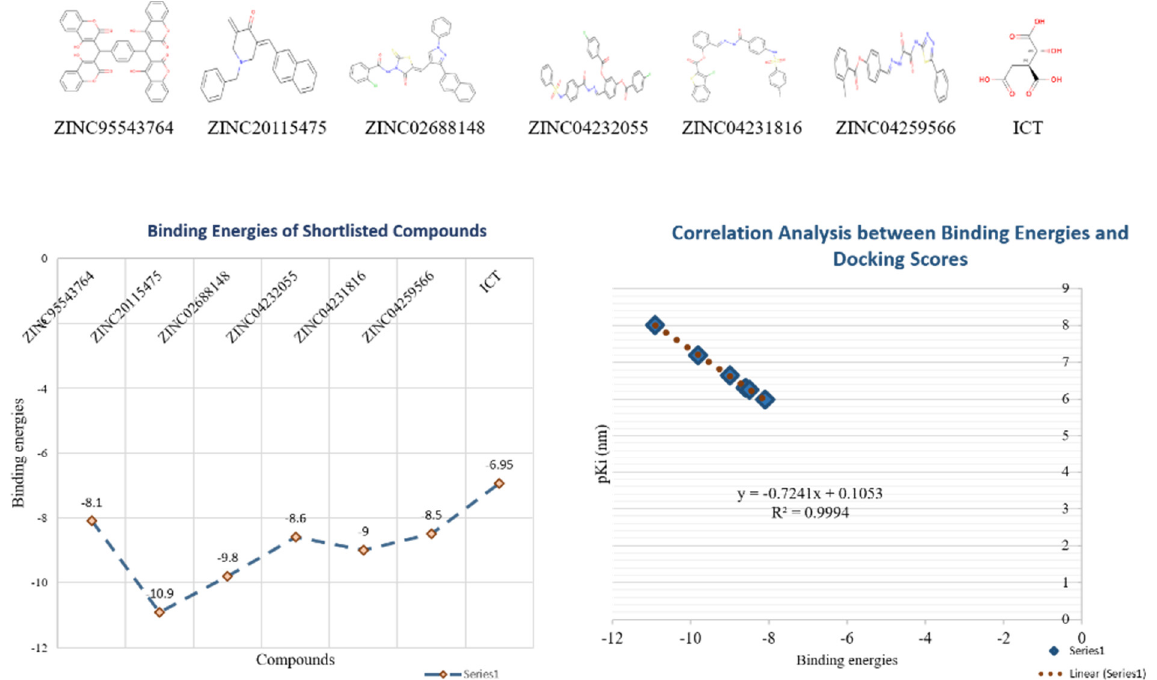
Figure 10. Correlation analysis for Ki and binding energies: the correlation analysis for six shortlisted compounds for ICL among Ki and binding energies. It shows the string regression correlation with R 2 = 0.99.